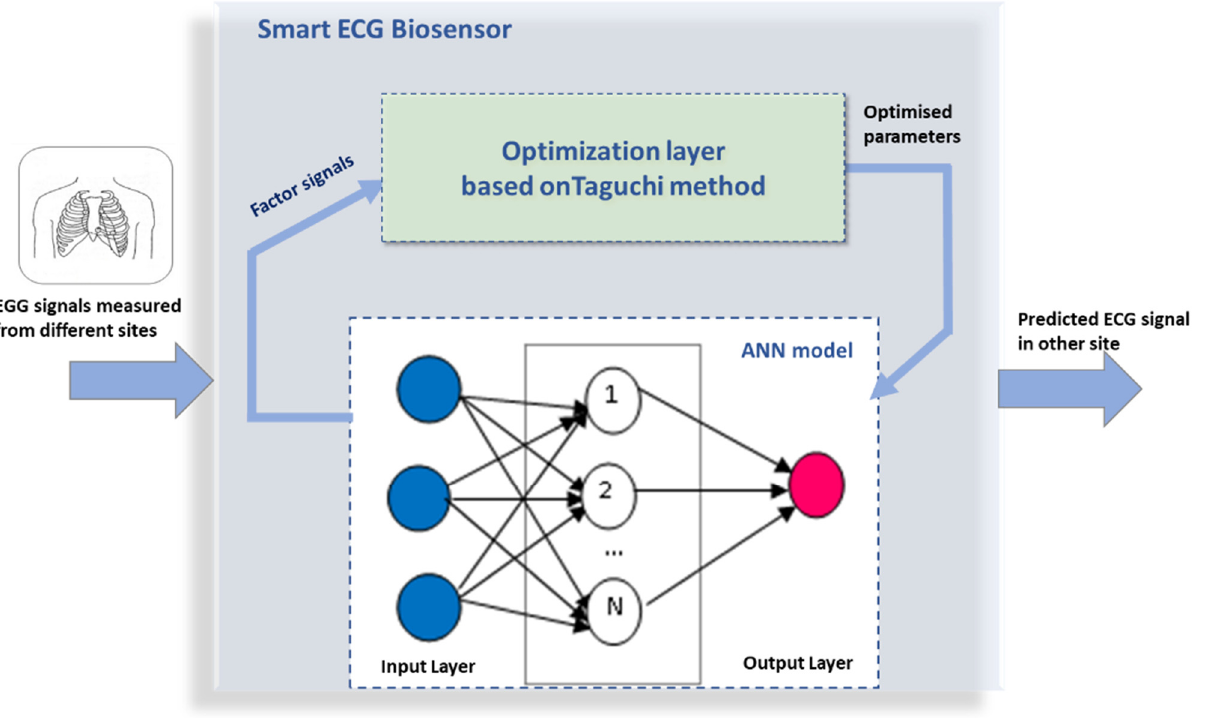
Figure 1. Overview of the architecture of the proposed ECG biosensor.